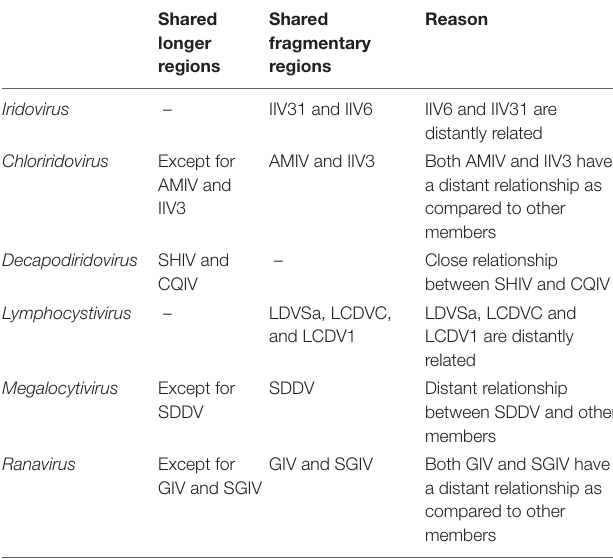
TABLE 1 | The specific collinearity in the indicated genera.